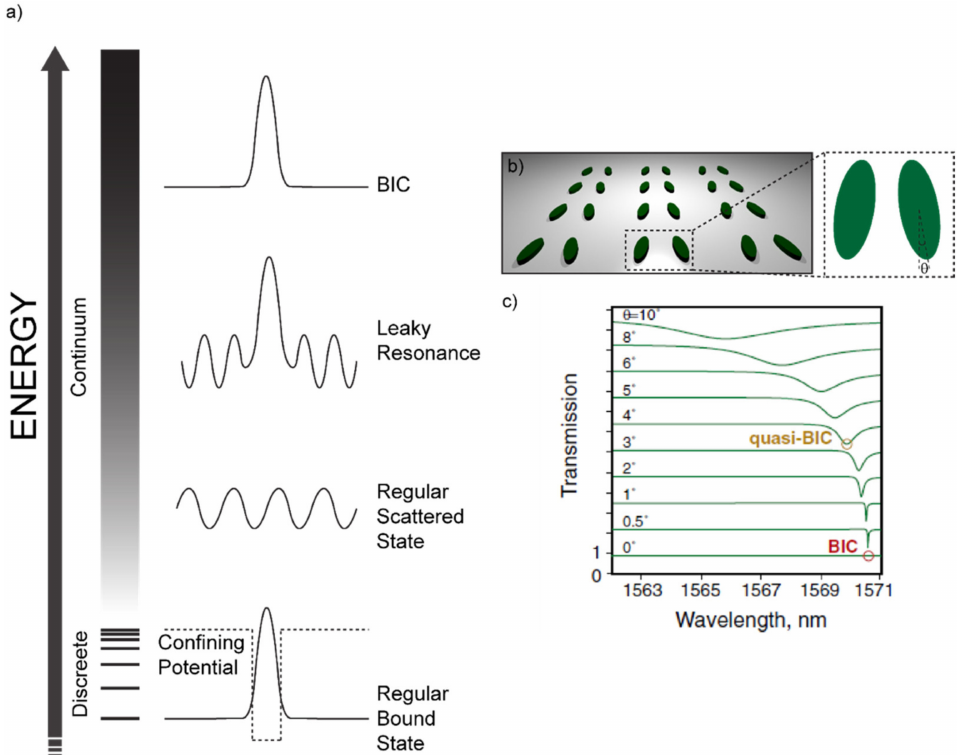
Figure 3. Bound States in the Continuum : ( a ) Sketch of the possible states in the “discrete” and in the “continuum” sets. If a potential is structured in such a way that only a discrete set of modes is allowed, then regular bound states will appear due to the confinement action of the potential itself. If the energy is higher than the height of the potential barrier, a continuum of allowed states is accessed. The simplest and most probable state in the continuum is a regular scattered state. A so-called “leaky resonance” can occur in the continuum due to some kind of destructive interference phenomenon that suppresses some of the radiative channels and forms a bound state. Such a leaky bound state or leaky resonance is also coupled to a scattered (radiative) wave and, therefore, can be accessed by free-space light. In the end, a Bound State in the Continuum (BIC) can occur if the aforementioned mechanism for the leaky resonances suppresses all the radiative channels, thus forming an ideal bound state in the continuum. The illustration is inspired by reference [71]. ( b ) Sketch of the architecture re-drawn from references [60,72], evidencing the tilt angle θ as the tuning parameter to access the quasi-BIC visible as steep minima in the transmittance spectrum shown in ( c ). Reproduced from reference [60].